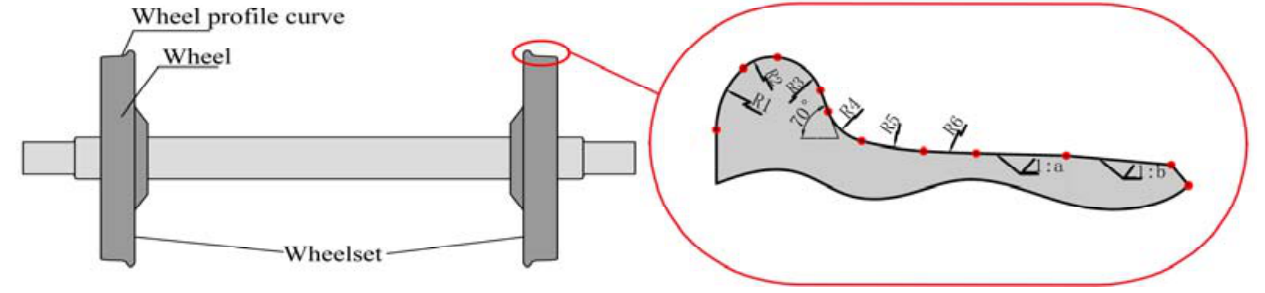
Figure 1. The complex curve of a wheel profile (unit: mm).